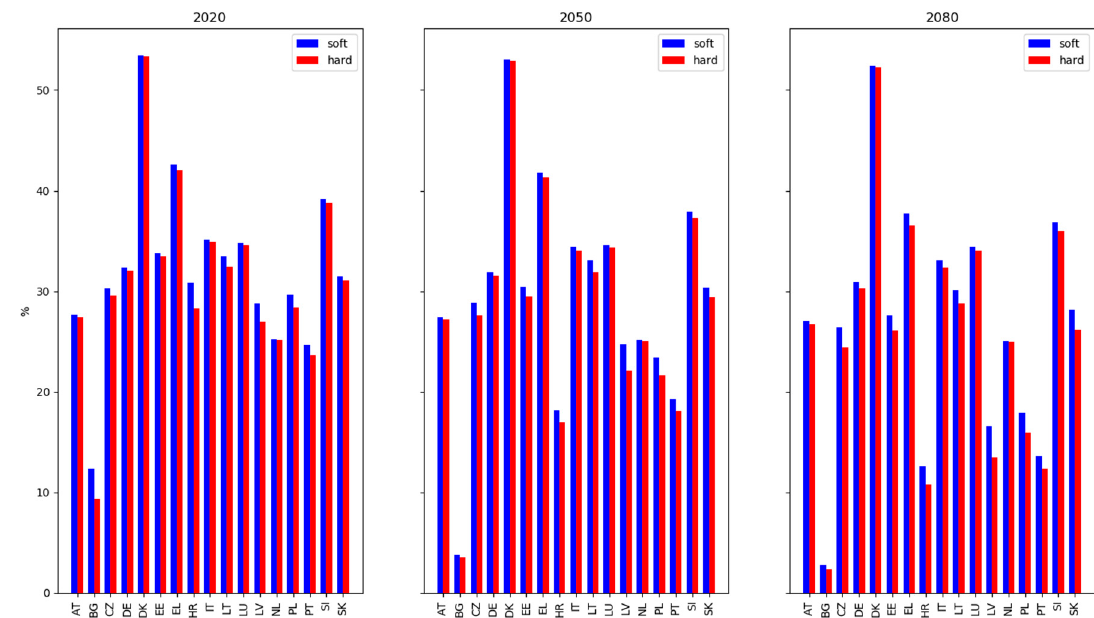
Figure 5. Percentage market penetration of voluntary insurance under soft market conditions (blue) and hard conditions (red) for EU countries, in 2020, 2050, and 2080, for RCP4.5. Countries that provide public reinsurance for flood insurance are excluded here, as these are not exposed to global reinsurance market volatility resulting from large natural catastrophes. Additionally, countries with semi-voluntary insurance systems are excluded here, since insurance uptake is a mortgage requirement and is therefore less responsive to capital market shocks.